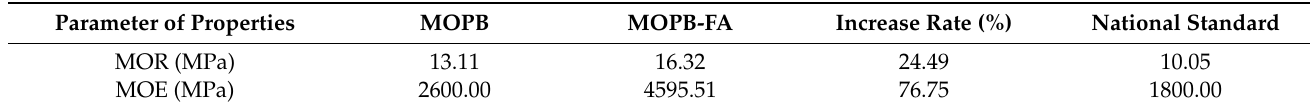
Table 7. Comparison of MOPB and